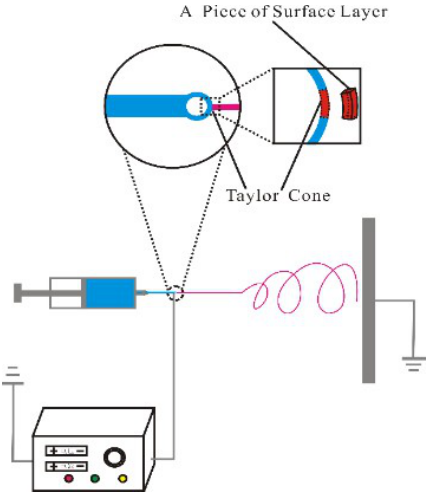
Figure 1. A control volume on the surface of Taylor cone.